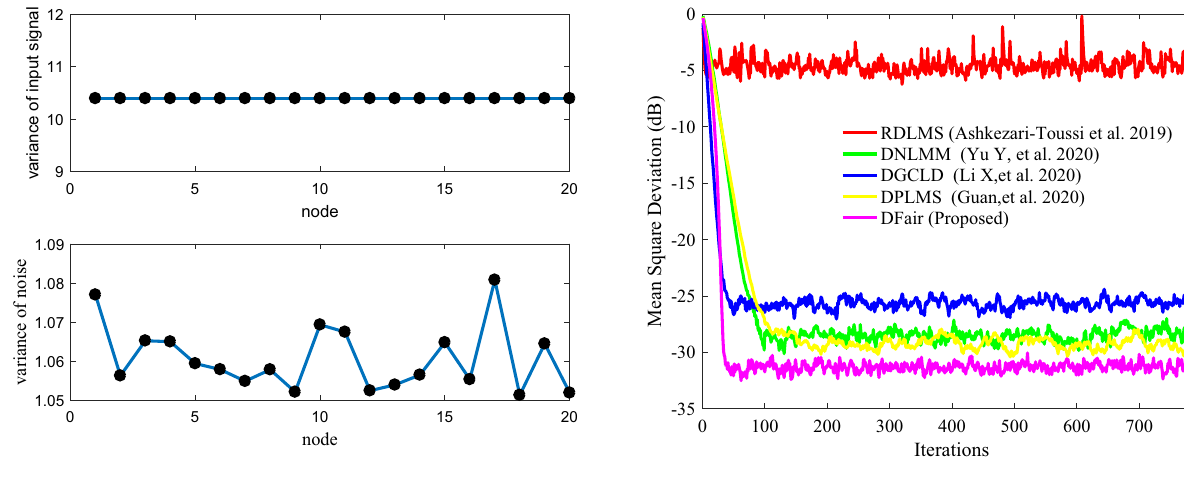
Figure 7. (Left_top) the input signals { X n ( i ) } variances of at each network node with R xx , n = σ 2 x , n I M , (Left_ bottom) the measurement interference variances ε n ( i ) at each network node; (Right) Transient network MSD (dB) iteration curves of the RDLMS, DNLMM, DGCLD, DPLMS, and DFair algorithms.